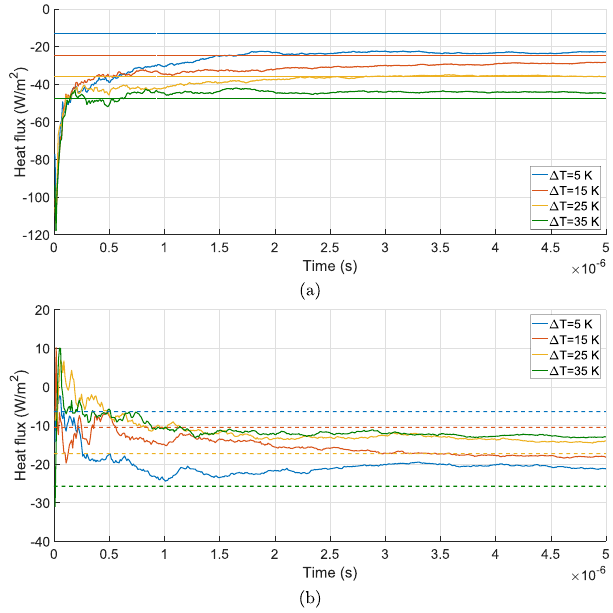
Figure 4. Comparison between the heat flux computed by the DSMC method (solid lines) and the one computed from the diffusive-approximate one (dashed lines) evaluated at the side walls of the hotter ( a ) and colder ( b ) microbolometers for different values of Δ T